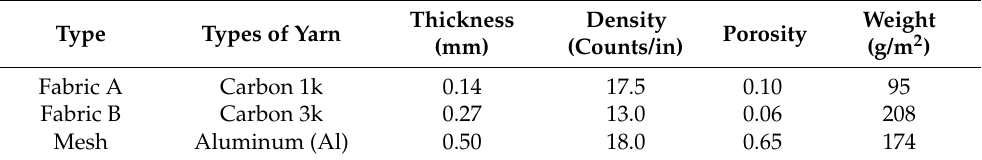
Figure 4. Images of the woven fabric and mesh: ( a ) fabric A (1k); ( b ) fabric B (3k); ( c ) mesh. Table 2. Geometric information of the woven fabrics and mesh.